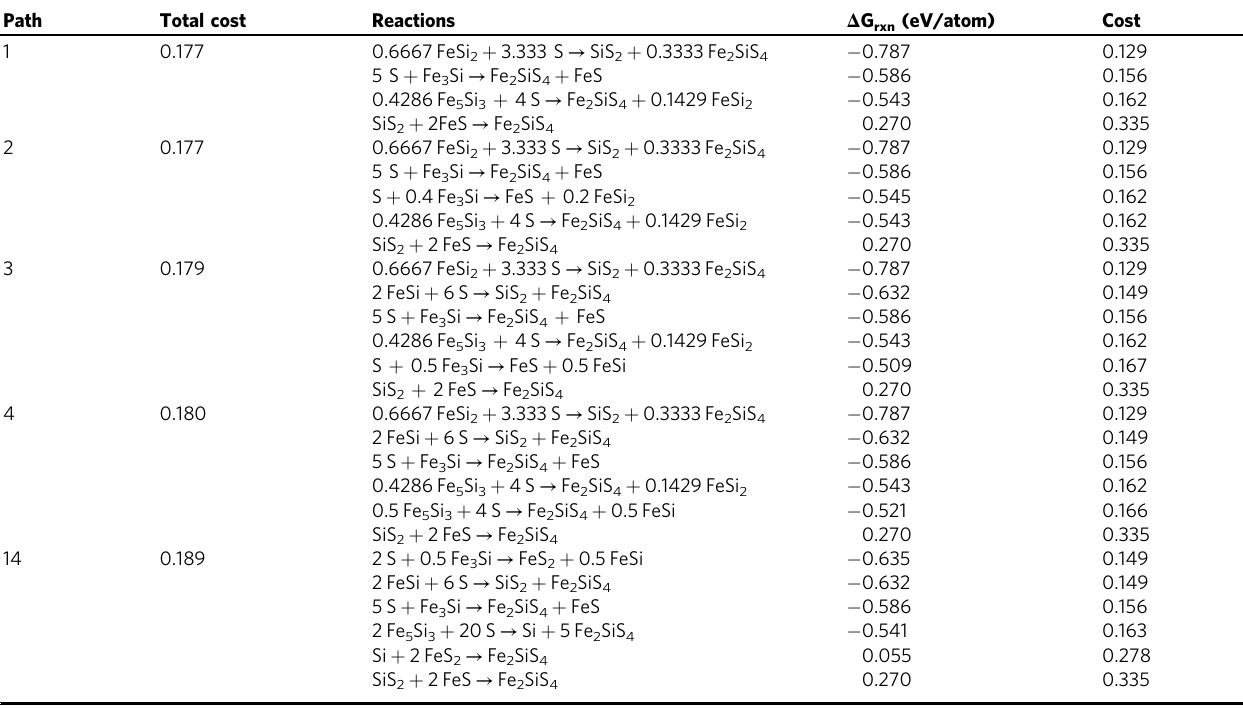
Table 3 Selection of top predicted reaction pathways to Fe 2 SiS 4 .